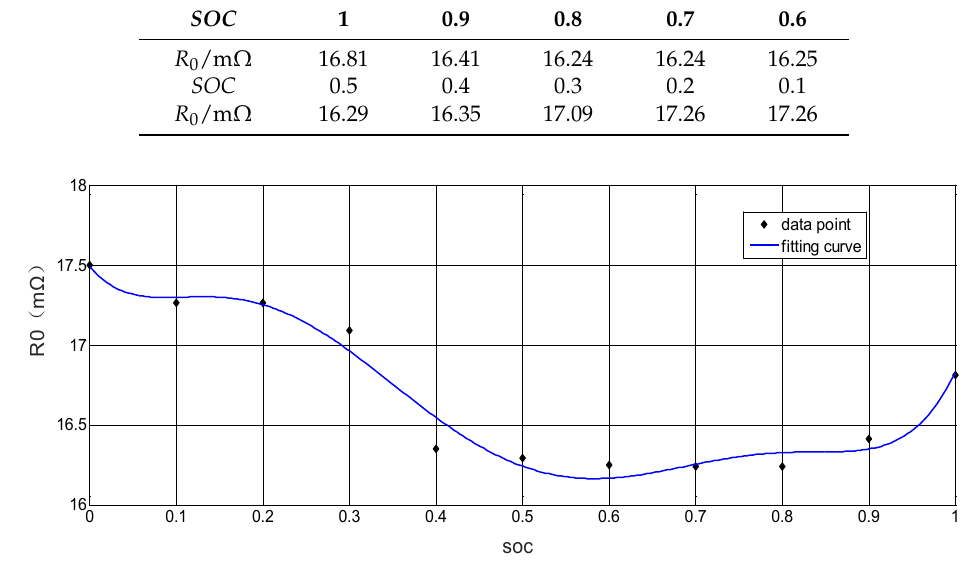
Table 3. The calculation results of battery cell internal resistance.